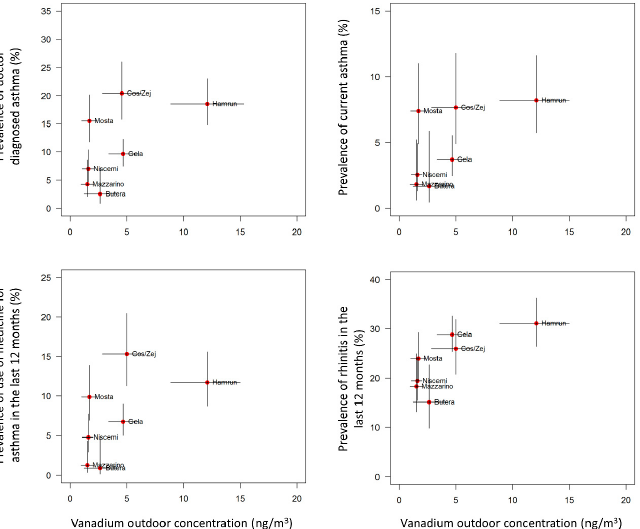
Figure 6. Schematic representation of the relationships between prevalence (and 95% confidence interval) of doctor diag- nosis of asthma, current asthma, use of medicine for asthma in the last 12 months, and rhinitis in the last 12 months, and outdoor vanadium concentration (mean and 95% confidence interval) per each community (Cos/Zej: Cospicua/Zejtun). In the original article, there were some mistakes in Table 1 as published. Due to a material error, most of the percentages (not the absolute values) in the table were errone- ously indicated . The corrected Table 1 appears below. The authors apologize for any in- convenience caused and state that the scientific conclusions are unaffected. The original article has been updated.